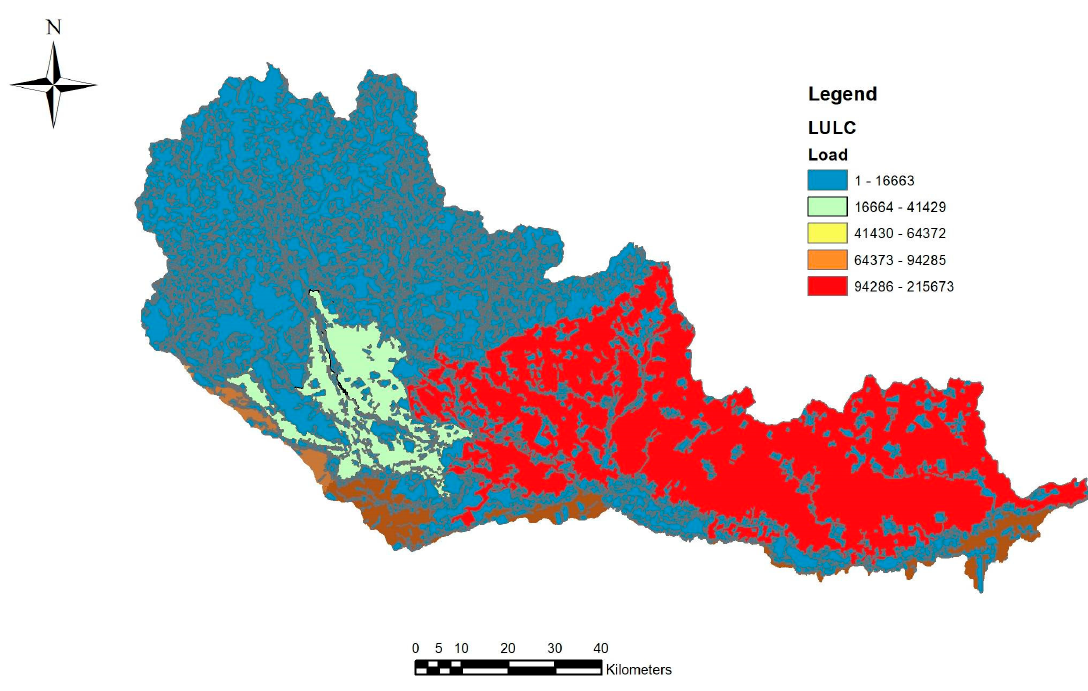
Figure 3. Potential pollutant load—suspended solids (TSS, kg/year) resulted from the expected mean concentration (EMC) model.